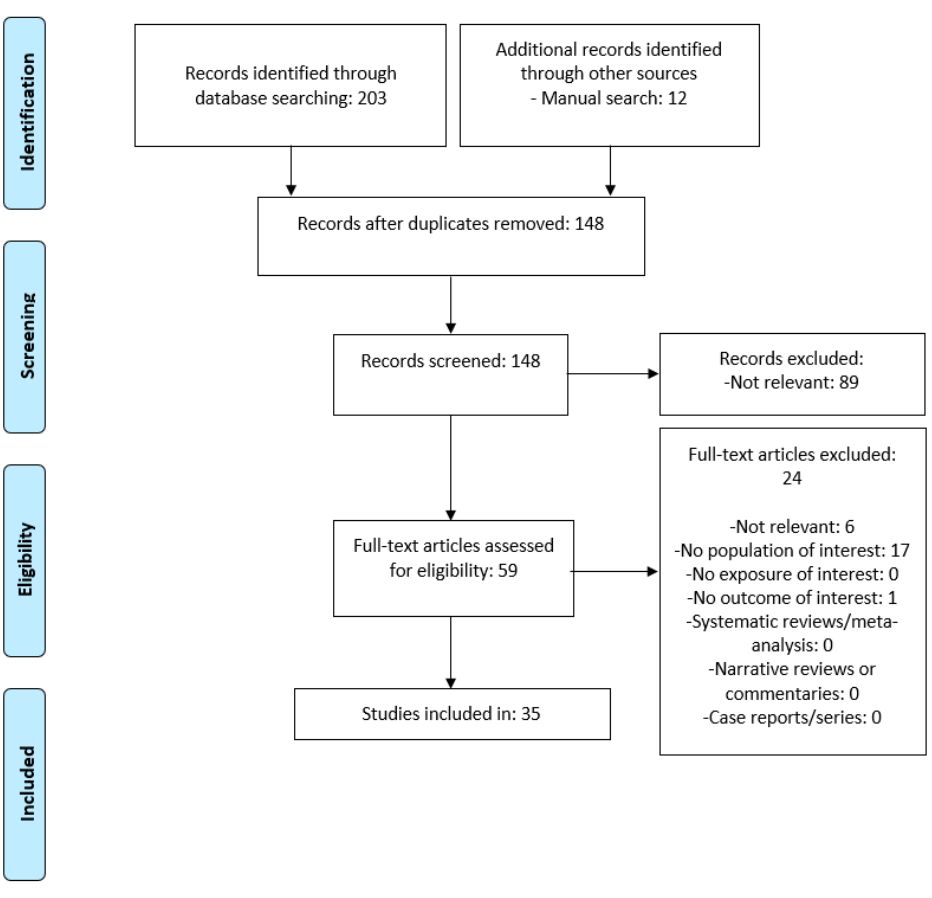
Figure 1. Flow diagram of the narrative review.